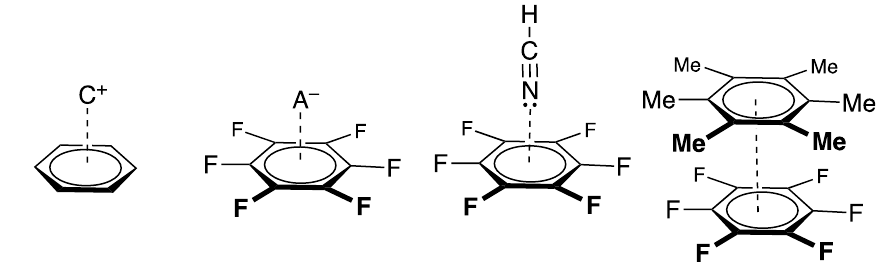
Figure 15. Cation- π , anion- π , lone pair –π and π - π stacking.